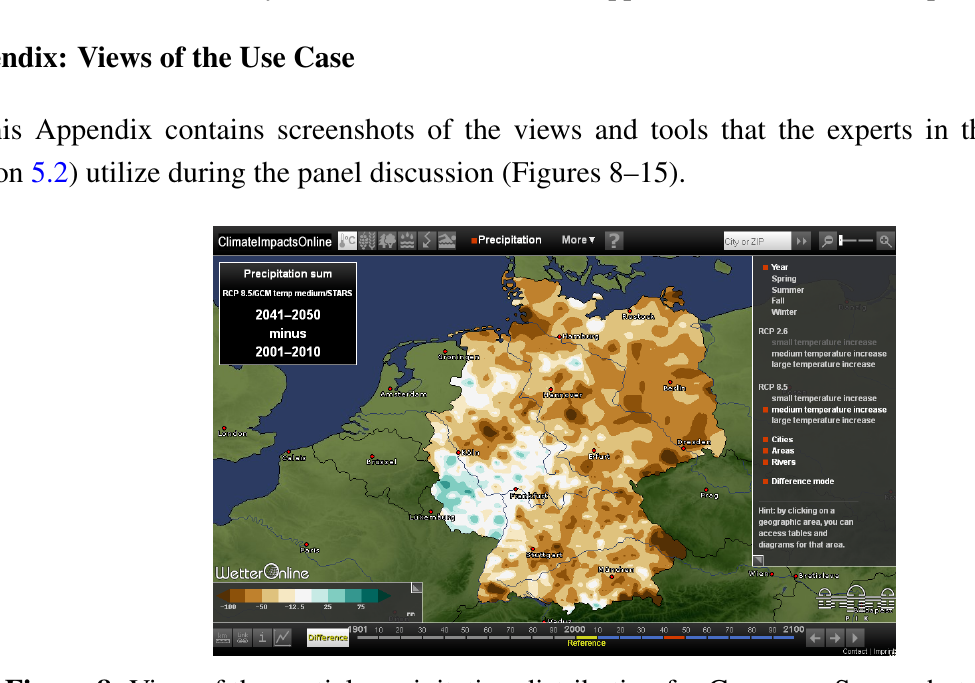
Figure 8. View of the spatial precipitation distribution for Germany. Screenshot taken from ClimateImpactsOnline